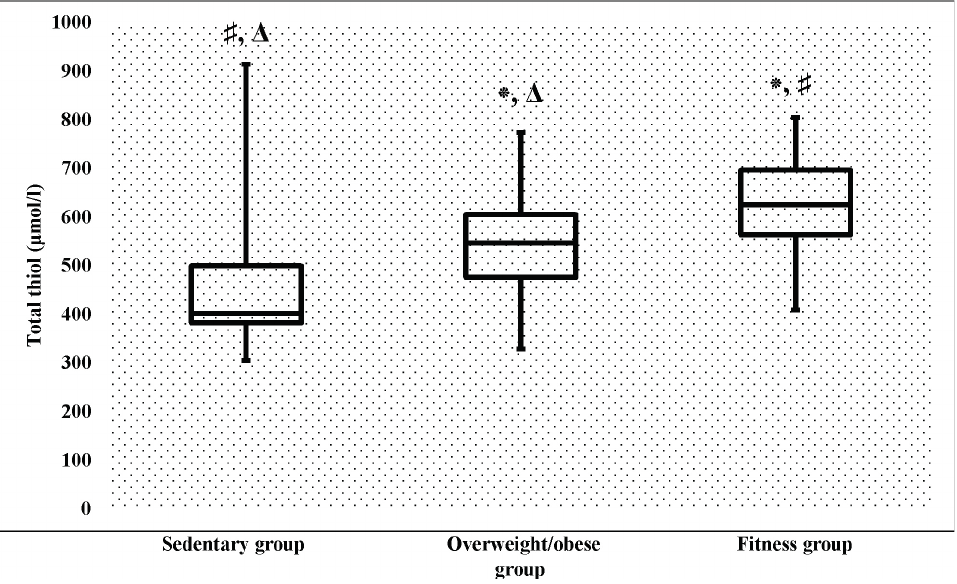
Figure 1 - Total thiol values of groups depicted by using boxplots. Total thiol values in fitness group are significantly higher than those in sedentary and oveweight/obese groups (p<0.001, p<0.05). In addition to that, total thiol levels of overweight/obese group are that of higher than sedentary group (p<0.05). Independent samples Kruskal Wallis median test was used to compare descriptics of the groups. For pairwise comparison, Dunn’s test, which gives adjusted p values was